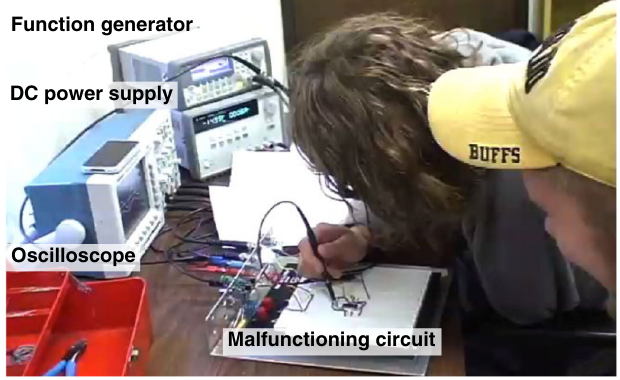
FIG. 4. Photograph of the setup for the TAPPS interview.